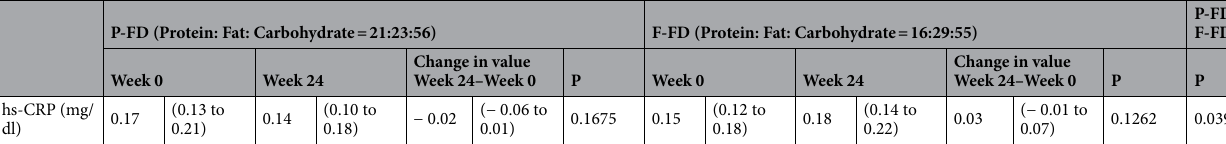
Table 2. Changes in clinical parameters and differences between P-FD group and F-FD group. P-FD protein- rich formula diet, F-FD fat-rich formula diet, BMI body fat mass, sBP systolic blood pressure; diastolic blood